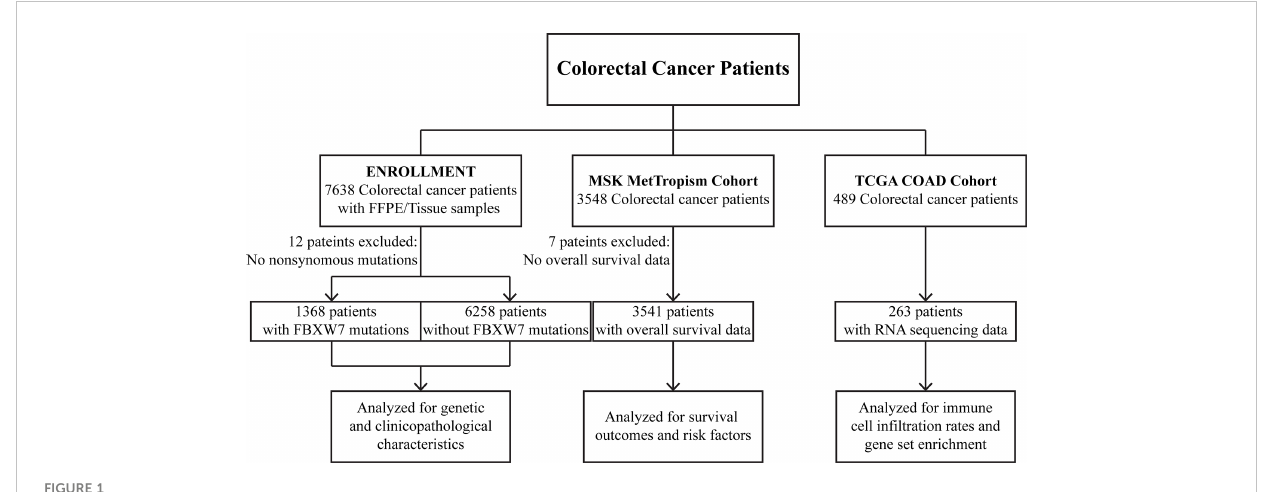
FIGURE 1 Flow chart of the